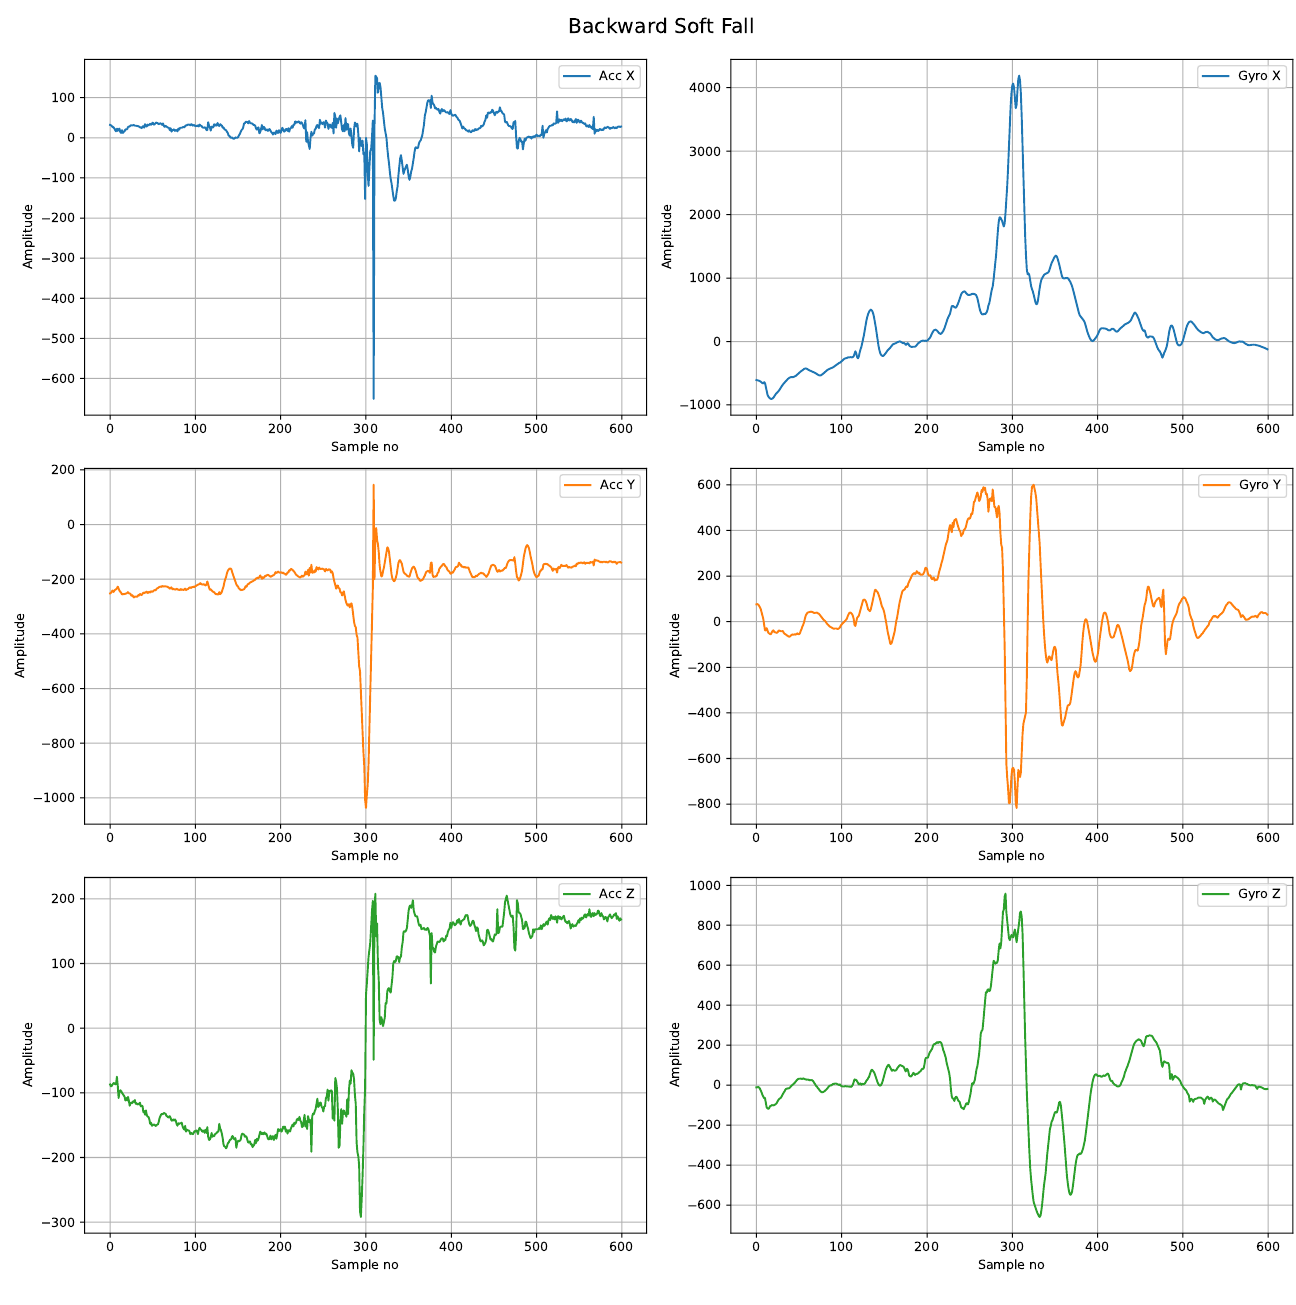
Figure A4. Accelerometer and gyroscope measurements: backward soft